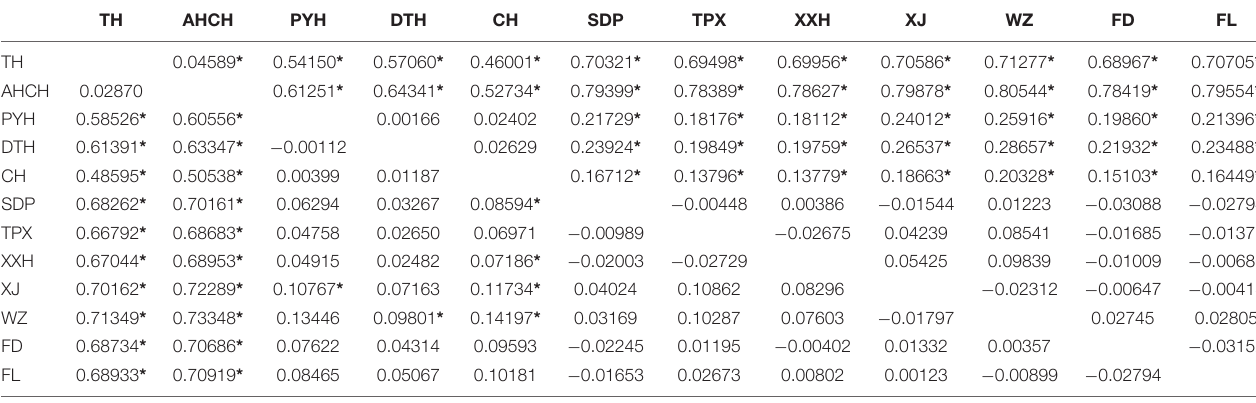
TABLE 2 | Pairwise F ST values based on Cyt b analysis of 424 samples (below diagonal) and D-Loop analysis of 408 samples (above diagonal) of C. brachygnathus from 12 different sites in the Yangtze River Basin, China.